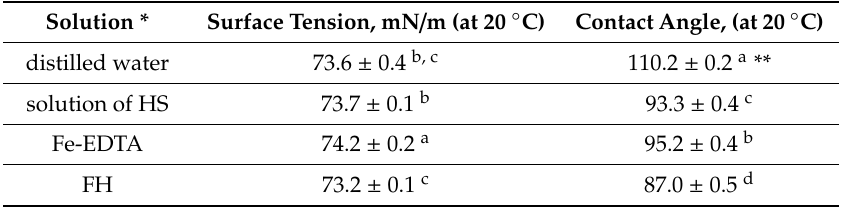
Table 2. Contact angles of the foliar spray droplets deposited on the surface of the wheat leaf and the surface tension of the corresponding solution.